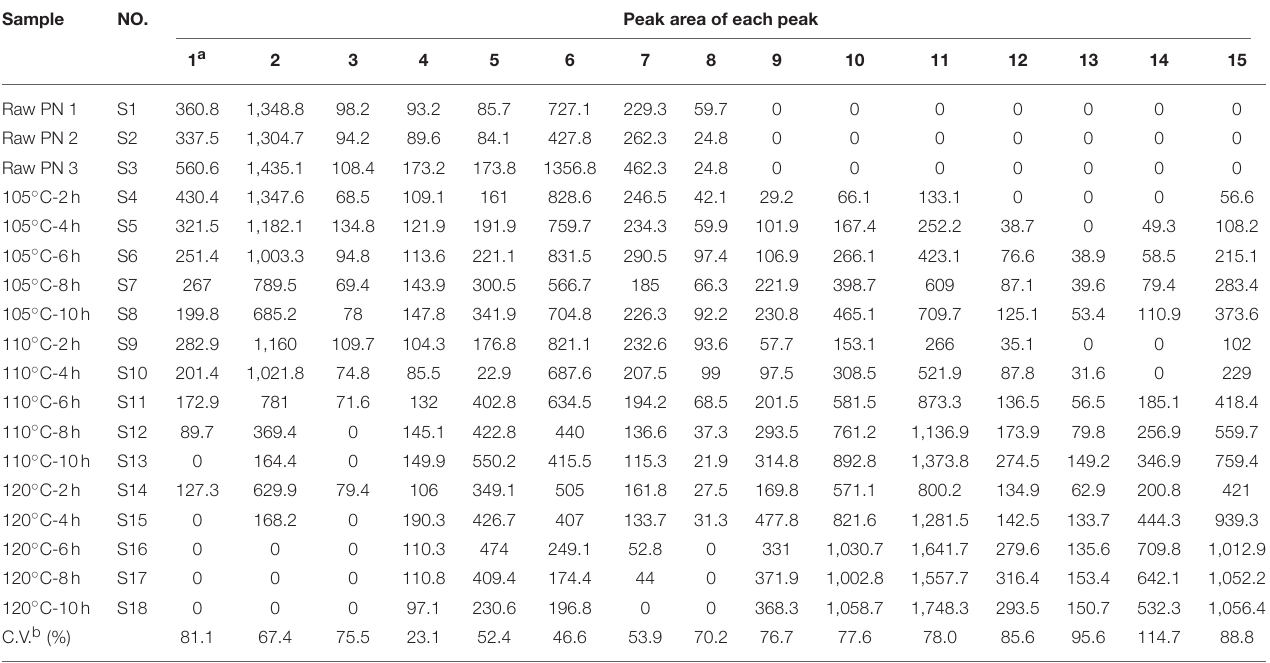
TABLE 1 | The samples information and peak area of fifteen common peaks in raw and steamed Panax notoginseng (PN) samples. Sample